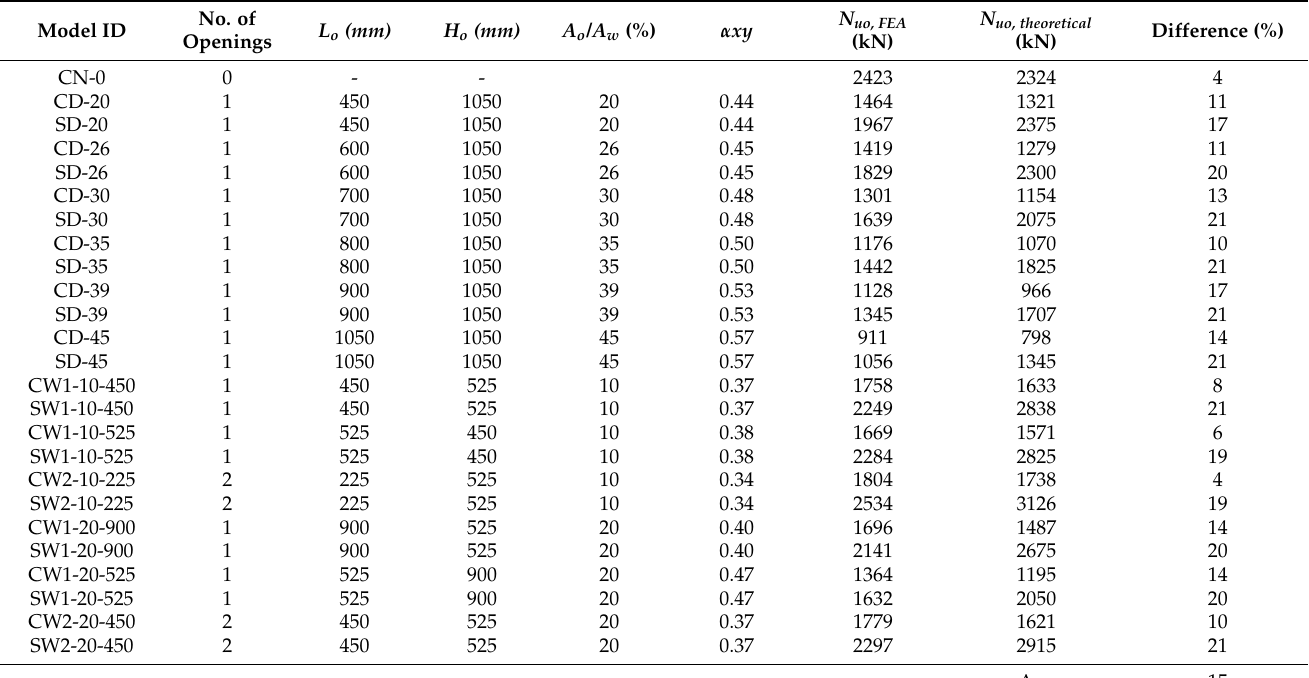
Table 7. Results of FEA and theoretical axial load